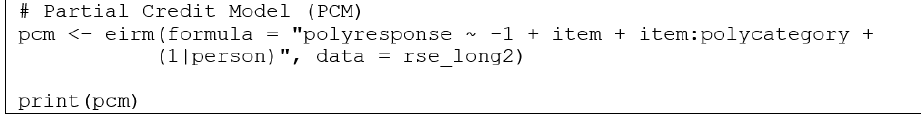
Figure 14. Estimate the partial credit model and print the model output.